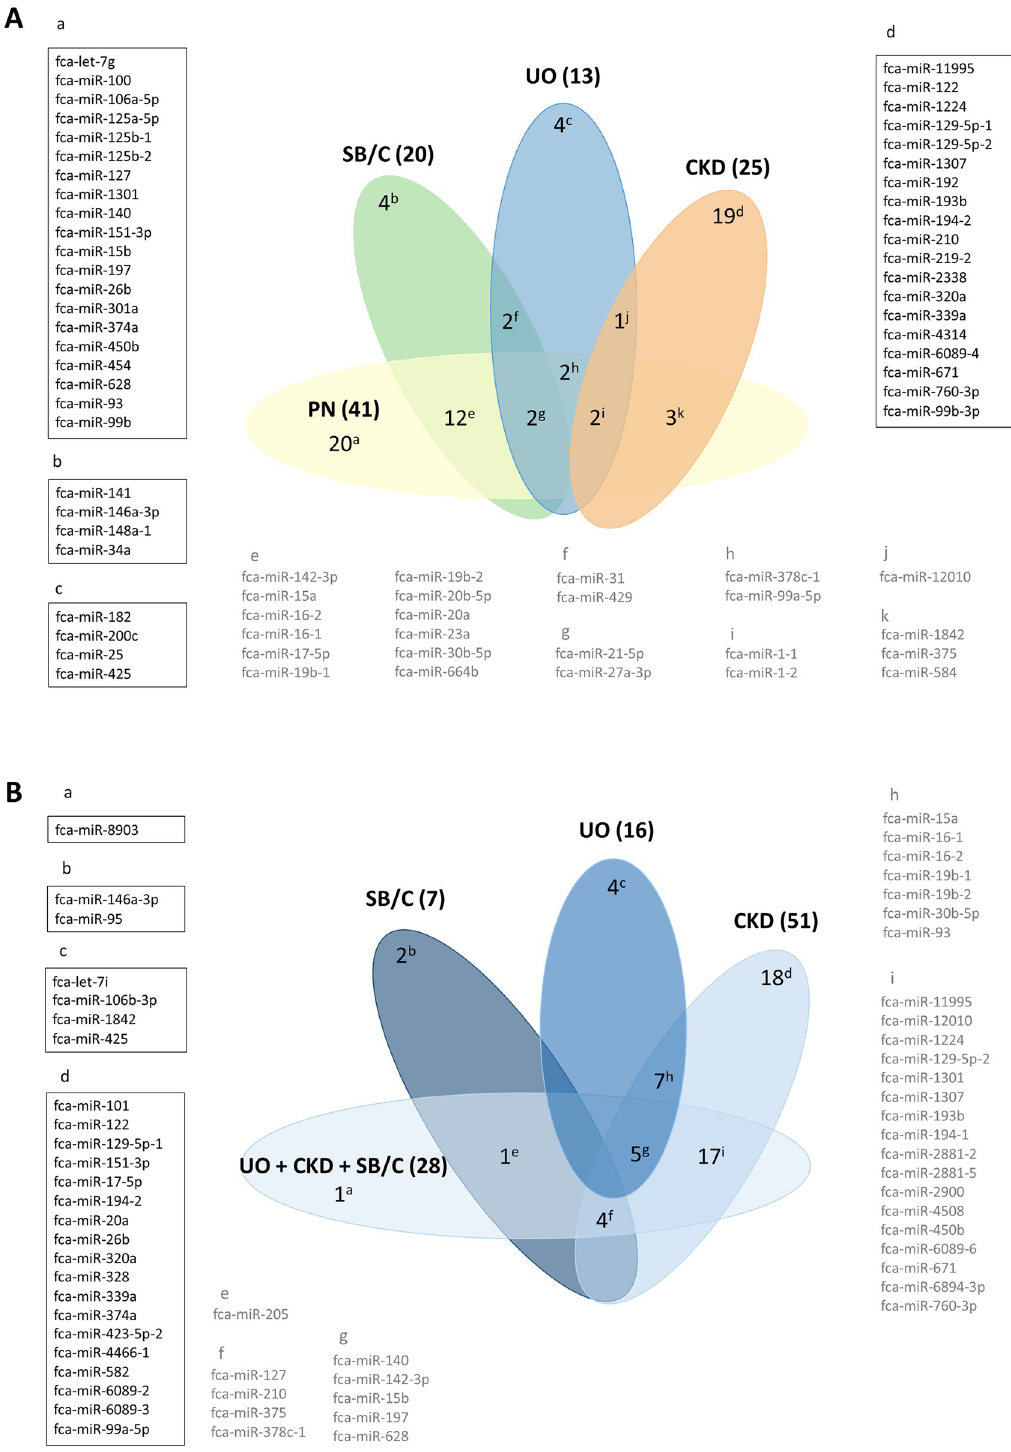
Fig 1. Venn diagram of the differentially abundant (DA) miRNAs in each of the analyzed comparisons. A. Shared and private miRNAs when comparing healthy cats (Control) with other pathologic urological conditions. In brackets, the total number of DA miRNAs in each comparison between healthy cats (Control) and cats with PN, SB/C, UO or CKD. B. Shared and private miRNAs when comparing cats with PN and cats with other urological conditions. In brackets, the total number of DA miRNAs in each comparison between PN cats and cats with SB/C, UO, CKD and all these disease states together (SB/C